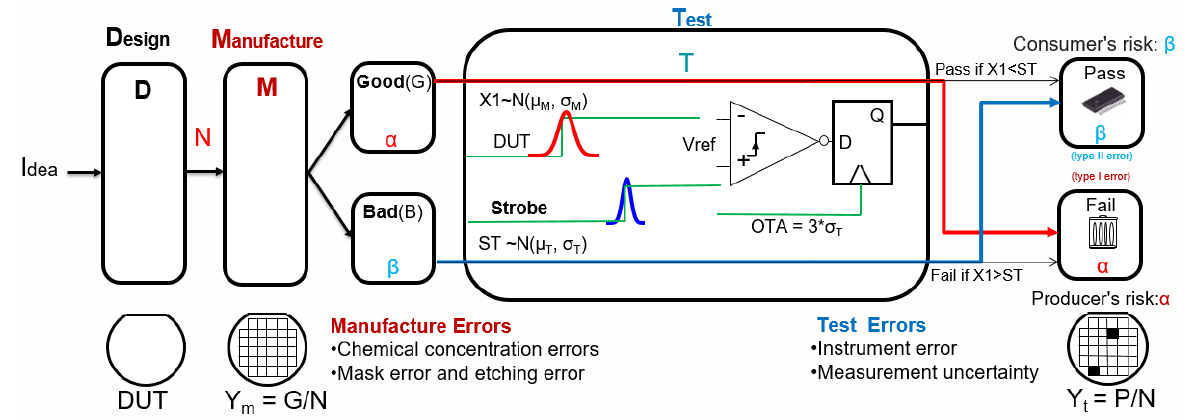
Figure 1. Very − large − scale integration VLSI chip development procedures.